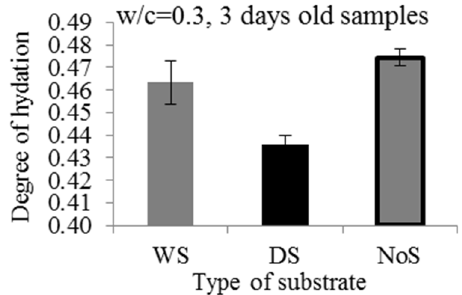
Figure 12. Influence of the mortar substrate saturation on the measured degree of hydration of the